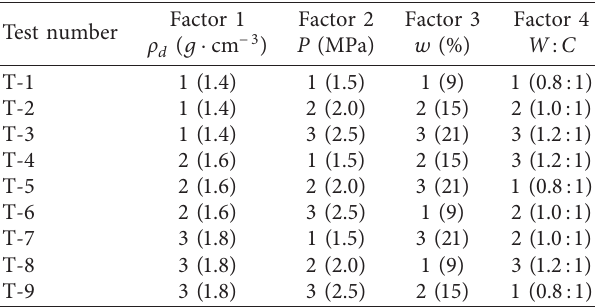
Table 2: Orthogonal test arrangement.